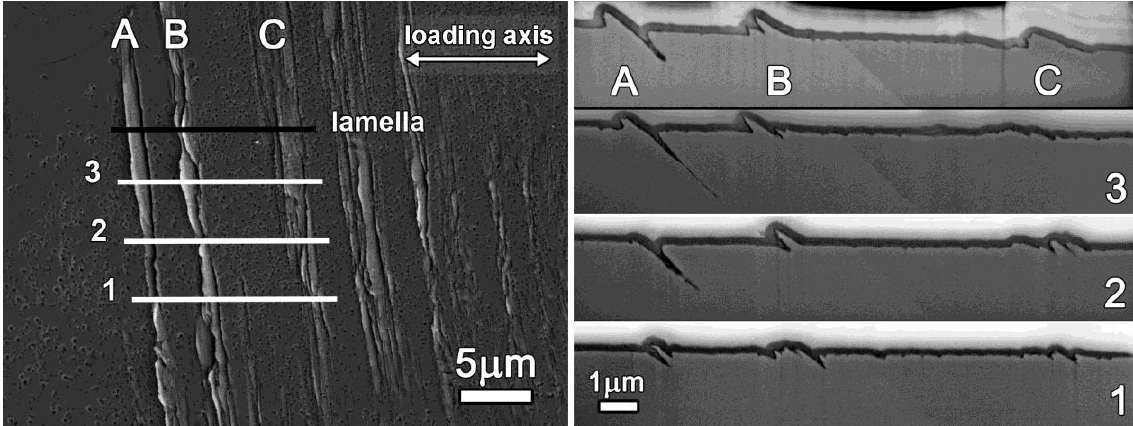
Figure 4. Surface of the polycrystalline copper cycled at room temperature and profiles of PSMs in individual FIB cuts imaged by field emission SEM (A, B and C are parallel PSMs, 1, 2 and 3 denote the positions of FIB cuts and lamella shows the position where TEM lamella was prepared).